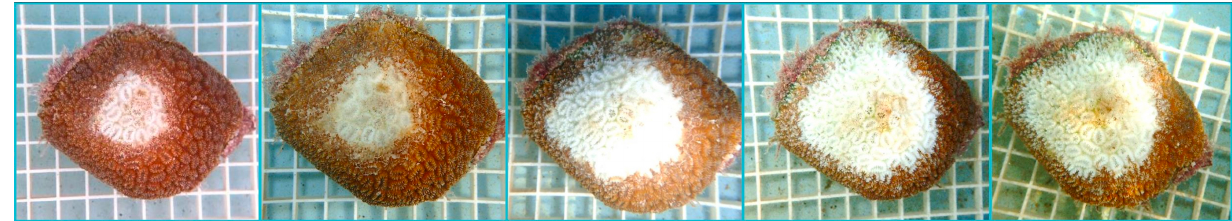
Figure 9: “Time series photos over five days show the rapid tissue loss on an infected coral.” Photo by Karen Neely, Nova Southeastern University, nd. Source: NonCommercial-NoDerivs 2.0 Generic (CC BY-NC-ND